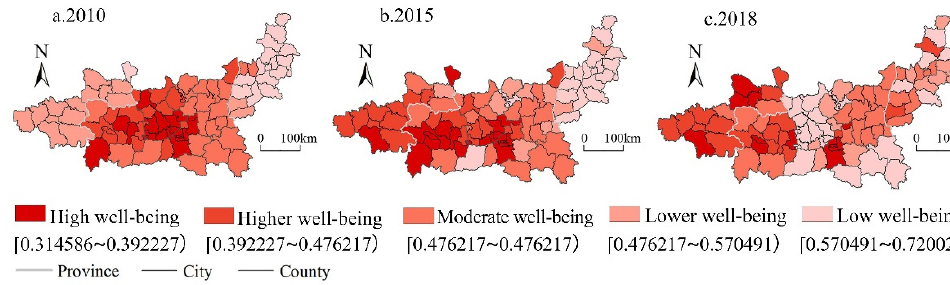
Figure 6. Spatial distribution of human well-being in Guanzhong Plain urban agglomeration from 2010 to 2018.